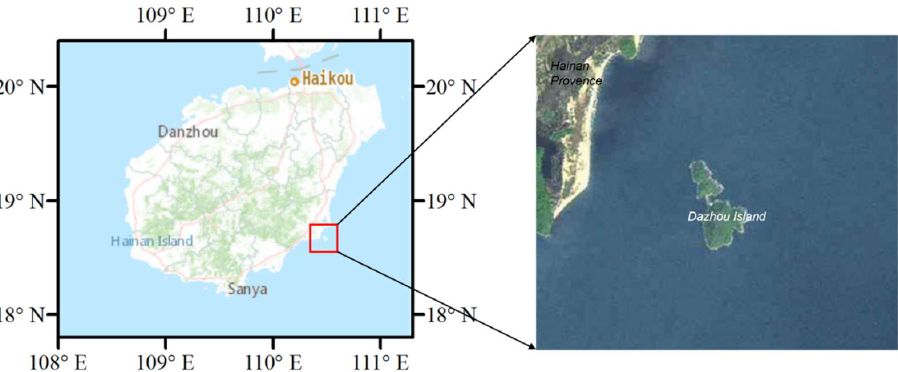
Figure 1. Schematic diagram of the study area, the detection area is the right figure. The left figure was produced from ArcGIS 10.2, and the right figure was produced from Google Earth.